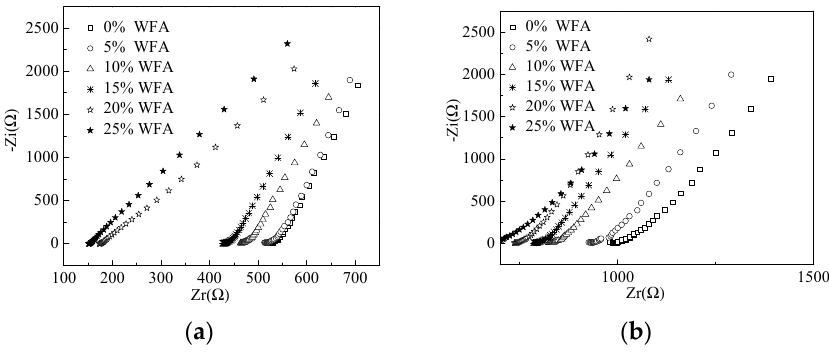
Figure 7. EIS curves of cement paste with different dosages of waste fly ash. ( a ) 1 d, ( b ) 28 d.